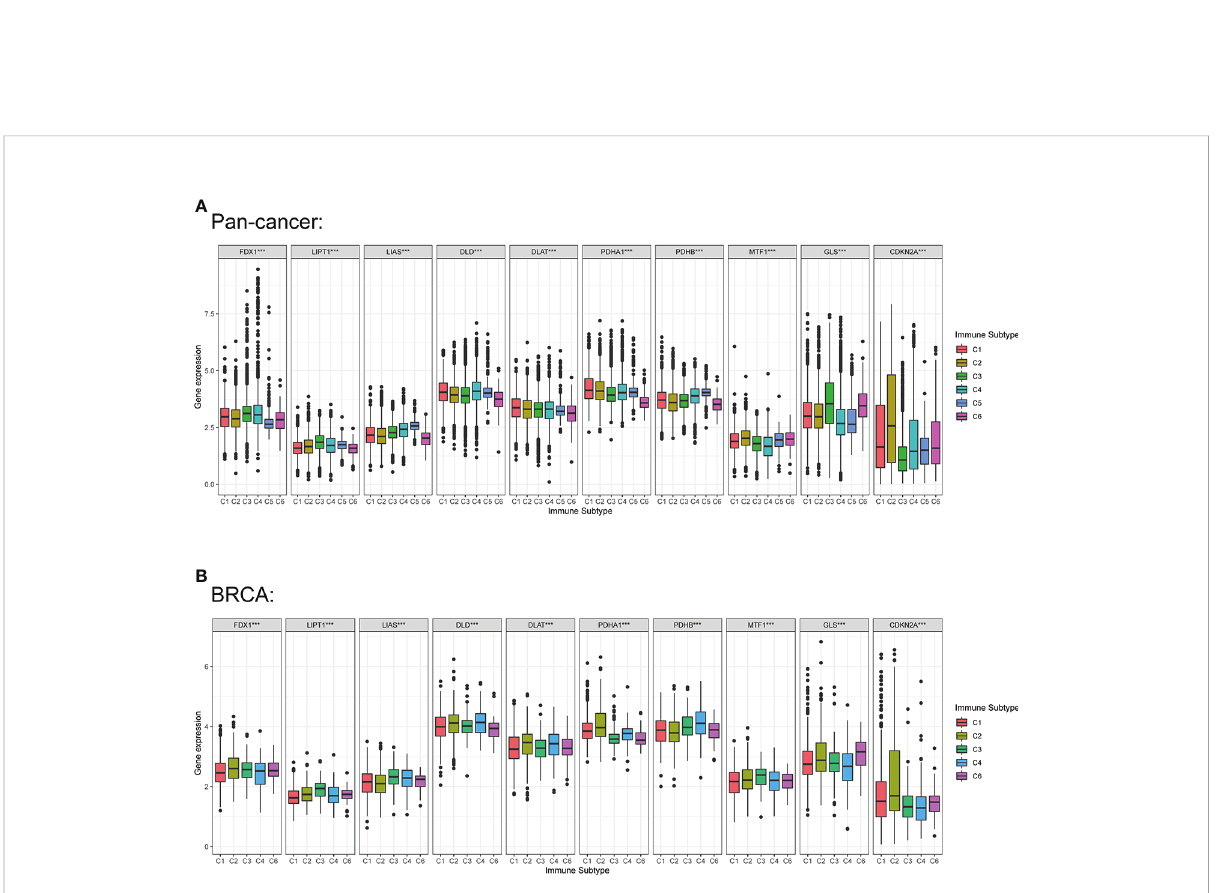
FIGURE 9 Correlation among expression levels of CRGs and different immune subtype in pan-cancer and BC. (A) CRGs expression levels in different immune subtypes in pan-cancer. (B) CRGs expression levels in different immune subtypes in BC. X axis is immune subtype, Y axis is gene expression. C1, wound healing; C2, IFN- g dominant; C3, in fl ammatory; C4, lymphocyte depleted; C5, immunologically quiet; C6, TGF- b dominant. P < 0.05, ***P <